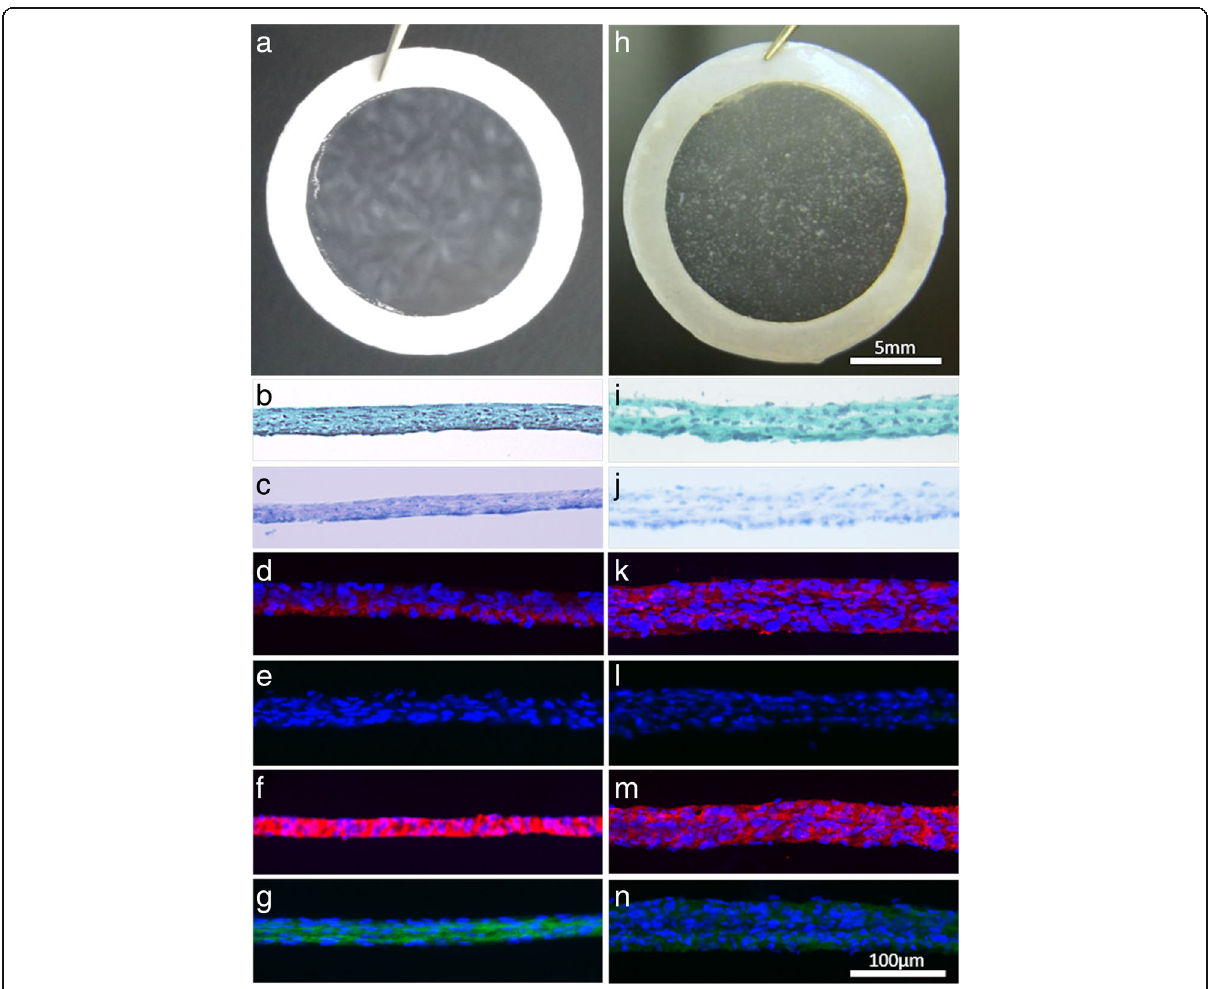
Fig. 3 Macroscopic images and microscopic images of histological sections. Images of PD sheets ( a – g ) and TKA sheets ( h – n ). a , h Representative images of a PD sheet and TKA sheet attached to a white PVDF membrane. Histological staining for Safranin O ( b , i ) and toluidine blue ( c , j ) showed either weak or no staining for all donors (×20). Immunostaining for COL1 (red; d , k ), COL2 (green; e , l ), ACAN (red; f , m ), and FN (green; g , n ) showed positive staining for COL1, ACAN, and FN but negative staining for COL2 (×20). (Scale bar = 100 μ